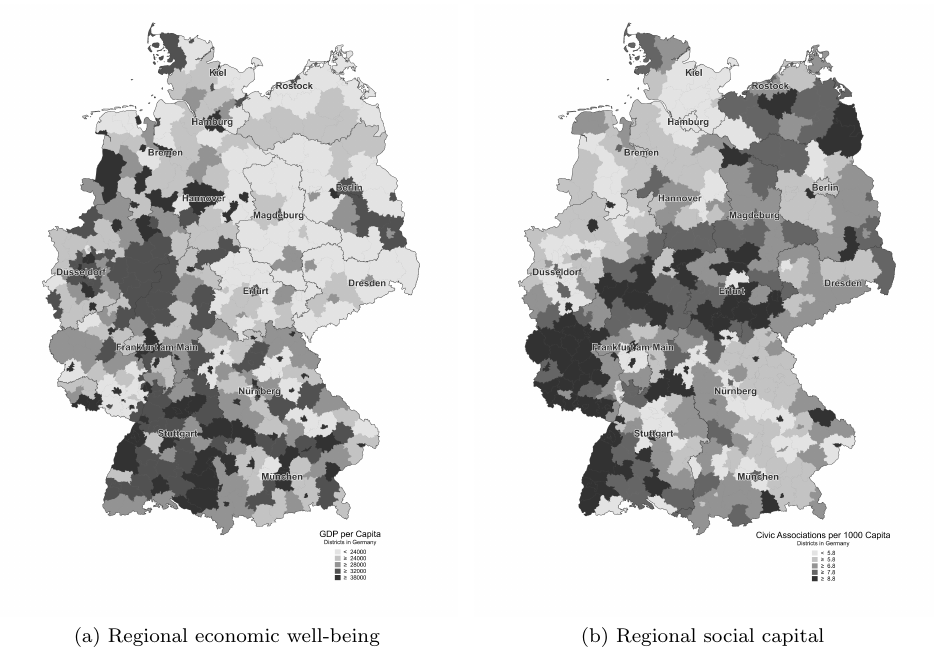
Figure 1: Maps of economic well-being and social capital (RegioGraph TM